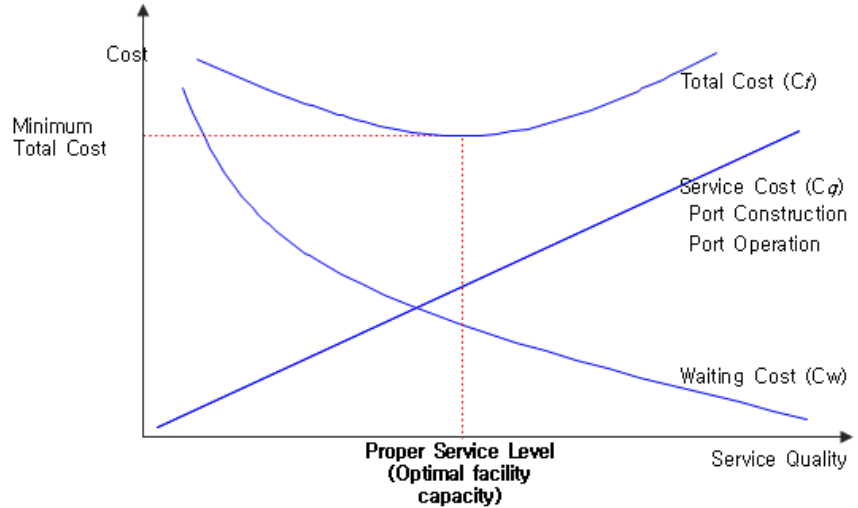
Figure 1. The relationship between port service quality and cost (Source: Park,S-K; Park,N-K. 2013 [7]).